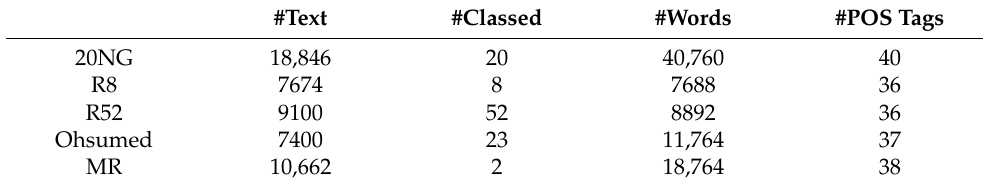
Table 1. Summary of short text datasets